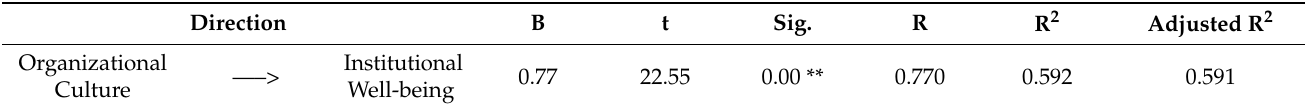
Table 6. Results of the